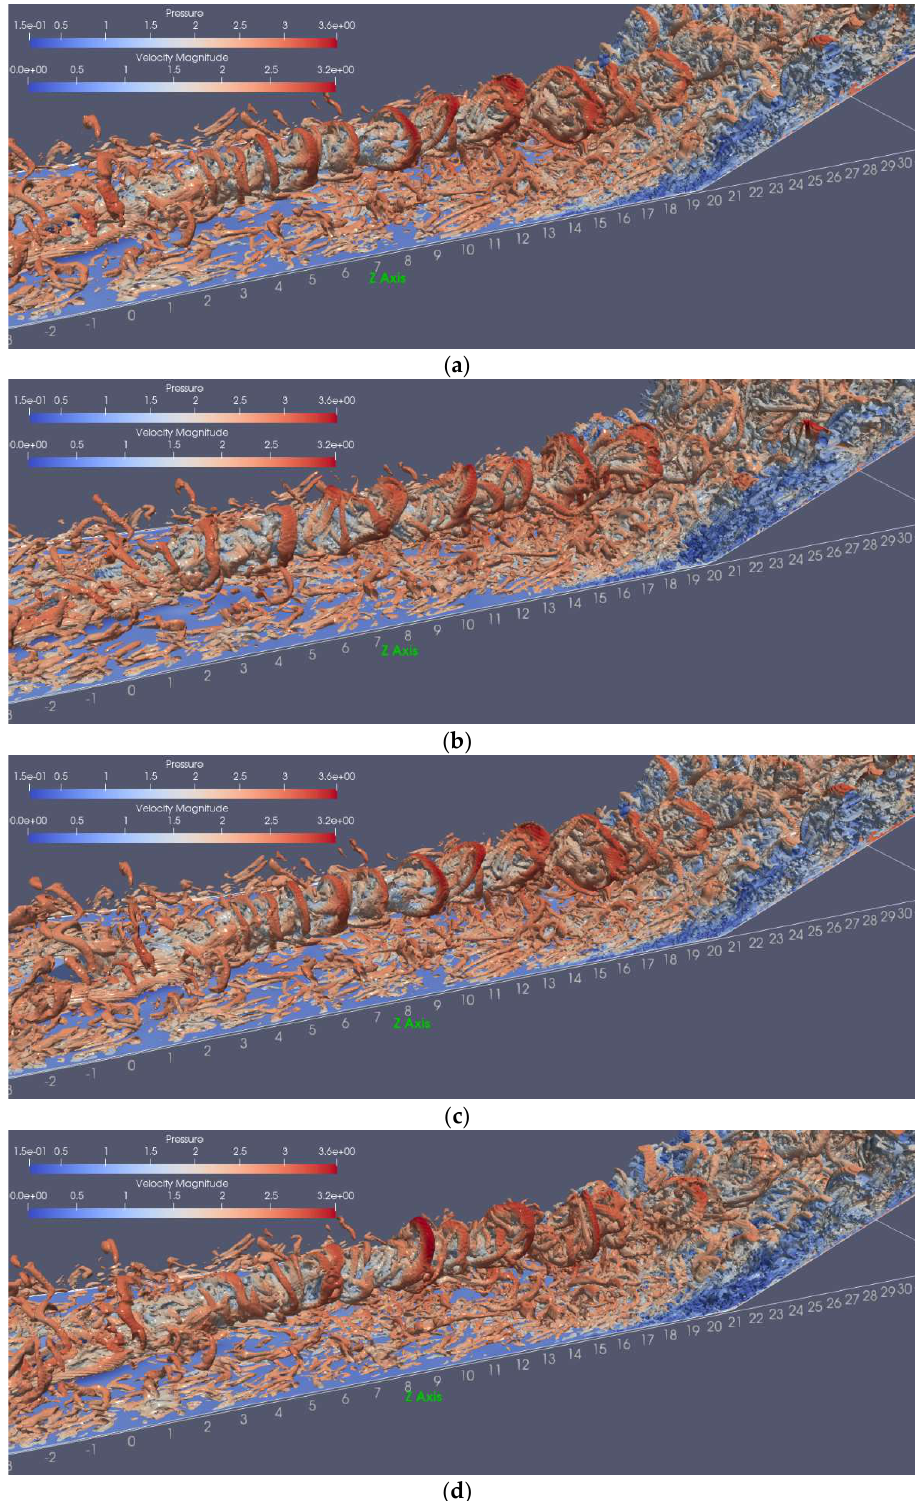
Figure 7. Vortex structure illustrated by Liutex iso-surface with ‖𝑅‖ = 0.3 , ( a ) case 1, ( b ) case 2, ( c ) case 3, ( d ) case 4.